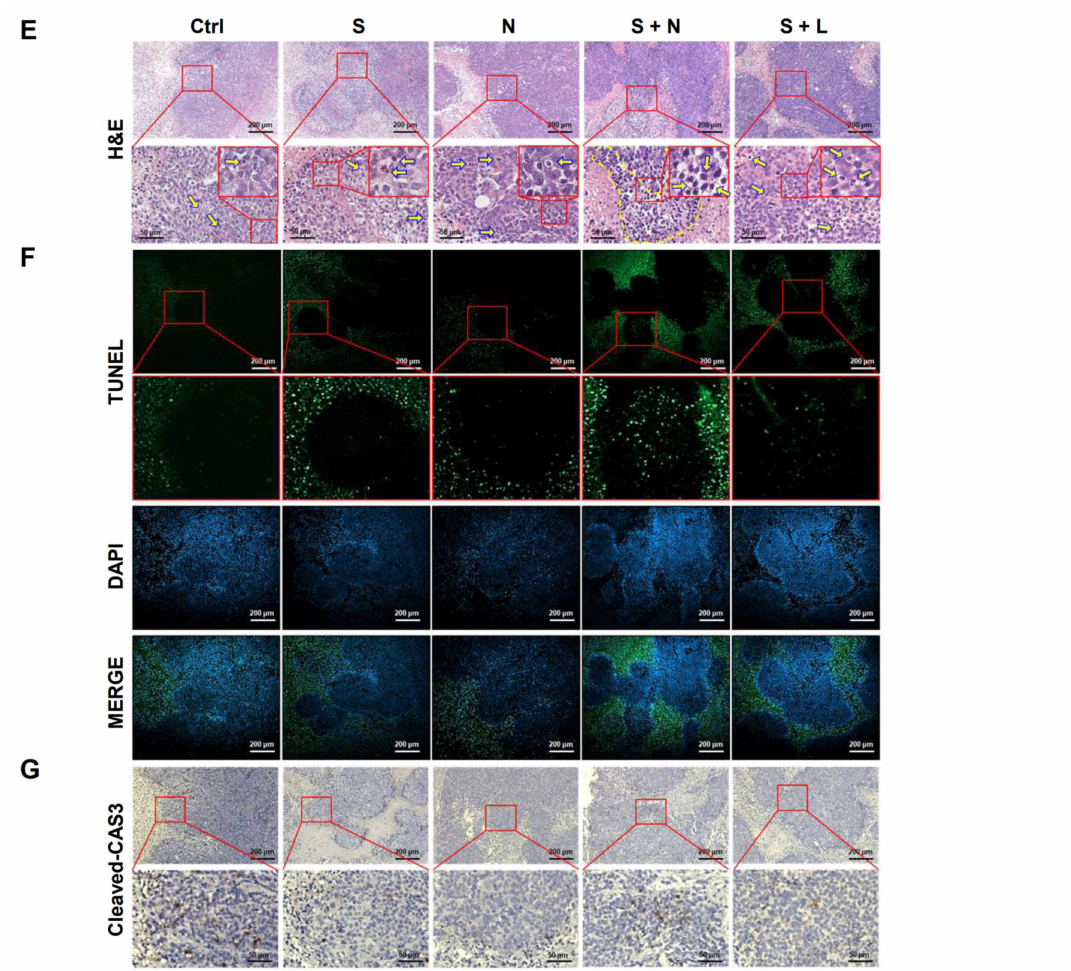
Figure 5. Combination treatment with niclosamide and sorafenib suppressed tumor growth and increased cell apoptosis in sorafenib-resistant xenograft tumors. ( A ) Schematic diagram of the animal model experimental design. ( B ) Tumor tissues of the different experimental conditions. Control group (Ctrl), sorafenib alone (S, 30 mg/kg), niclosamide alone (N, 40 mg/kg), niclosamide plus sorafenib (S + N), linsitinib (L, 20 mg/kg), and linsitinib plus sorafenib (S + L). ( C ) Tumor volume analysis. ( D ) Tumor weight analysis. ( E ) H&E staining of the sorafenib-resistant xenograft tumor tissues of different treatments. Control group (Ctrl), sorafenib alone (S, 30 mg/kg), niclosamide alone (N, 40 mg/kg), niclosamide plus sorafenib (S + N), linsitinib (L, 20 mg/kg), and linsitinib plus sorafenib (S + L). ( F ) TUNEL immunostaining (in green) and DAPI staining (in blue) of ( G ). Expression levels and cellular localization of cleaved caspase 3 protein (cleaved-CAS3) in xenograft of sorafenib-resistant HepG2215_R tumor tissues are shown. Scale bar, 100 µ m. * p < 0.05, ** p < 0.01, *** p < 0.001, and **** p < 0.0001, as obtained from one-way